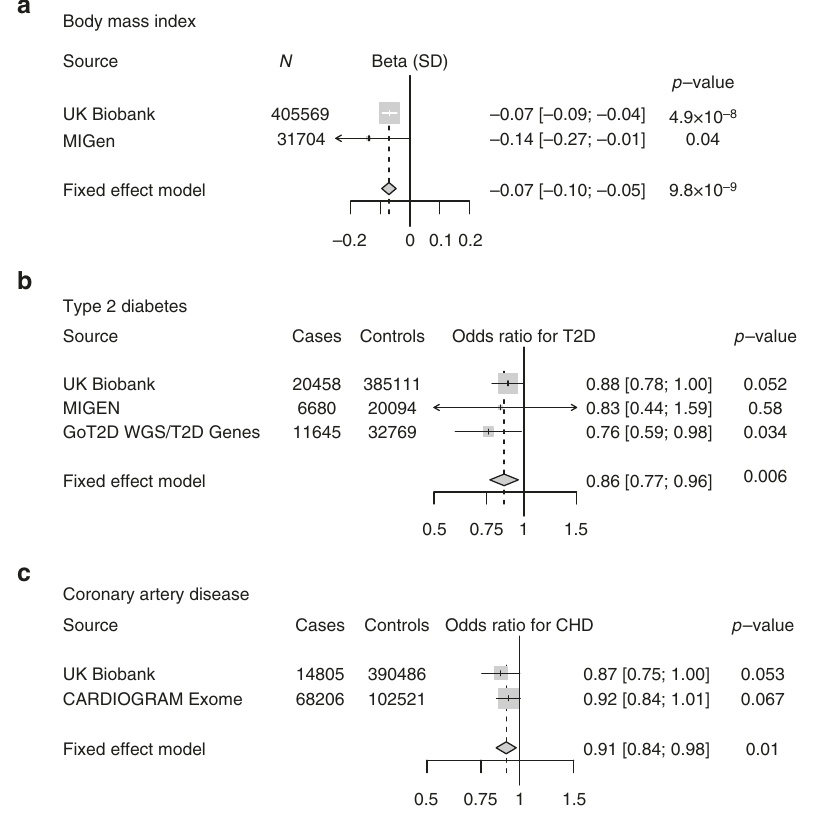
Fig. 1 Association of a loss-of-function variant (p.Arg95Ter) in GPR151 with a body mass index, b type 2 diabetes, and c coronary artery disease. Estimates were derived in UK Biobank using logistic regression, adjusted for age, sex, ten principal components of ancestry, and array